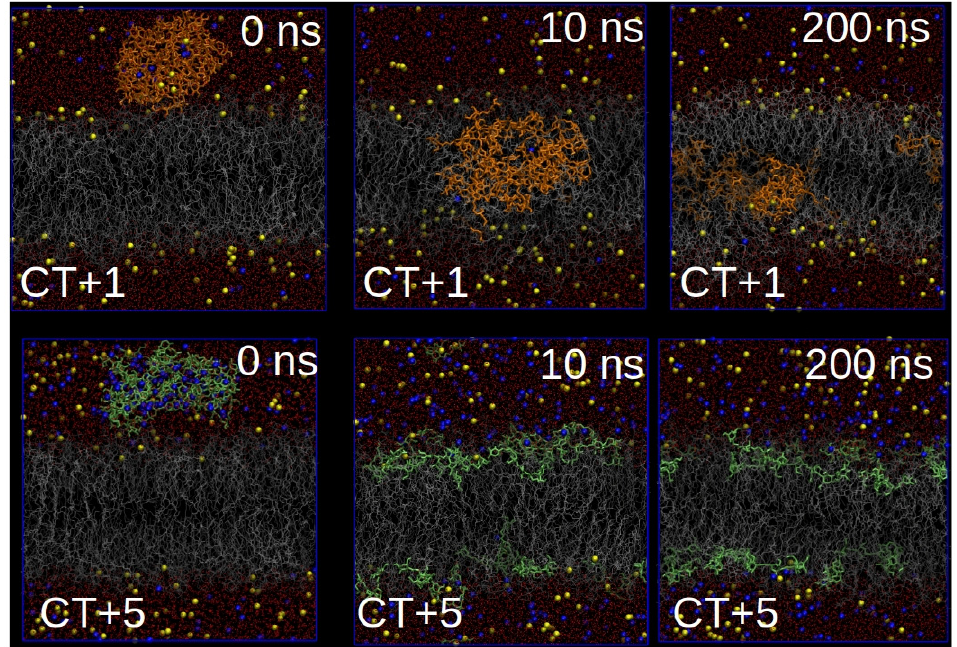
Figure 3. Cartoon corresponding to different snapshots related with the interaction of the two different models of aggregates of chitosan with different charge, CT+1 and CT+5. Red points: water, yellow beads: Na+, blue beads: CL-, Orange bonds: CT+1, green bonds: CT+5, gray lines: DPPC and silver–gray lines: DPPS.